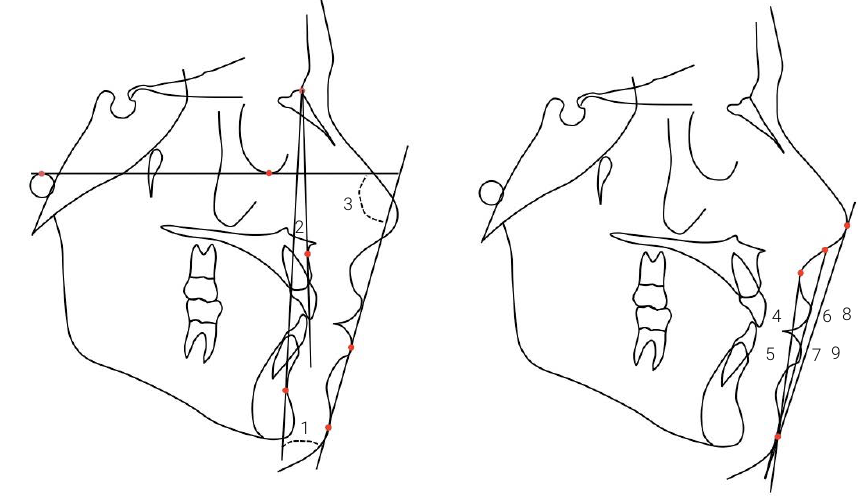
Figure 1. Measures used (1) H-Angle 9 ; (2) ANB angle 9 ; (3) Z-Angle 11 ; (4) Linear measurement from the most anterior point of the upper lip to the line joining the subnasal and Pogonion points 10 ; (5) Linear measurement from the most anterior point of the lower lip to the line joining the subnasal and Pogonion points 10 ; (6) Linear measurement from the most anterior point of the upper lip to the line joining the midpoints of the base of the nose to the Pogonion 6 ; (7) Linear measurement from the most anterior point of the lower lip to the line joining the midpoints of the base of the nose to the Pogonion 6 ; (8) Linear measurement from the most anterior point of the upper lip to the line connecting the tip of the nose and Pogonion points 8 ; (9) Linear measurement from the most anterior point of the lower lip to the line joining the tip of the